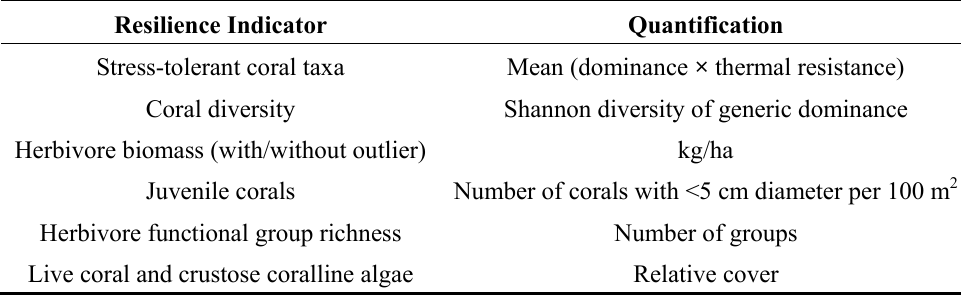
Table 2. Resilience indicators derived from field data and their quantification. “Herbivore biomass” was modelled both with and without the